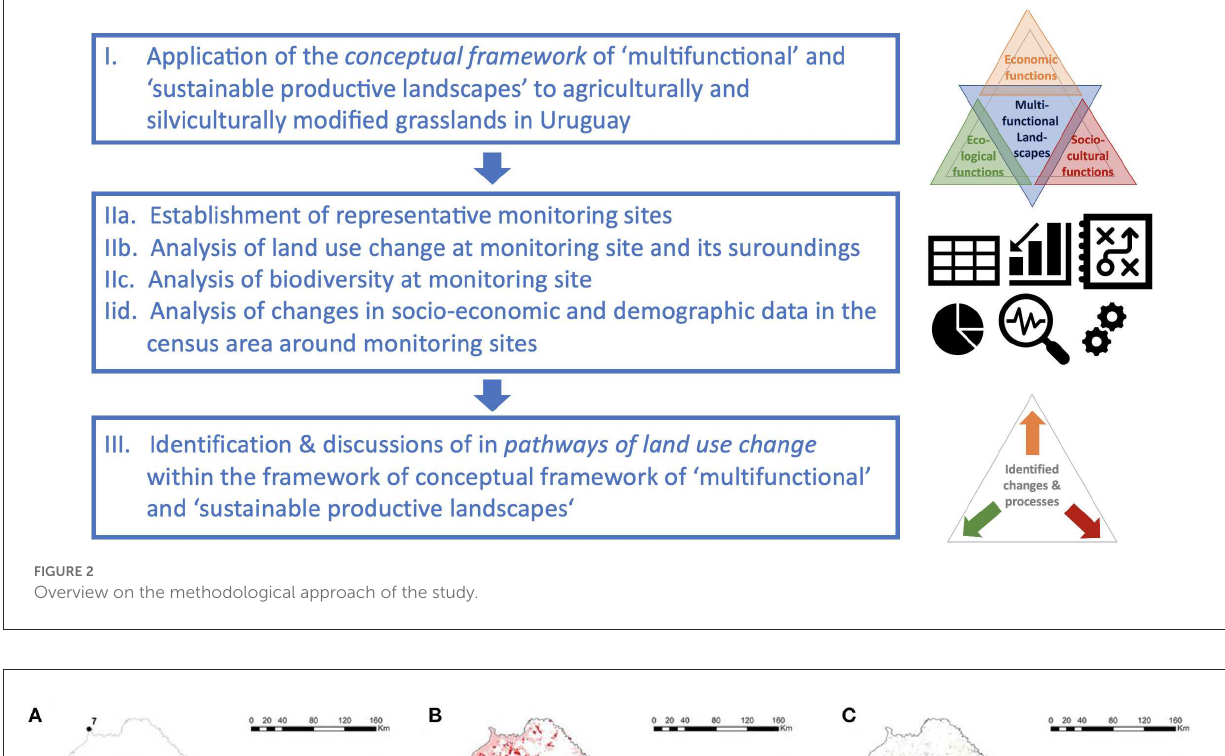
FIGURE2 Overview on the methodological approach of the study.